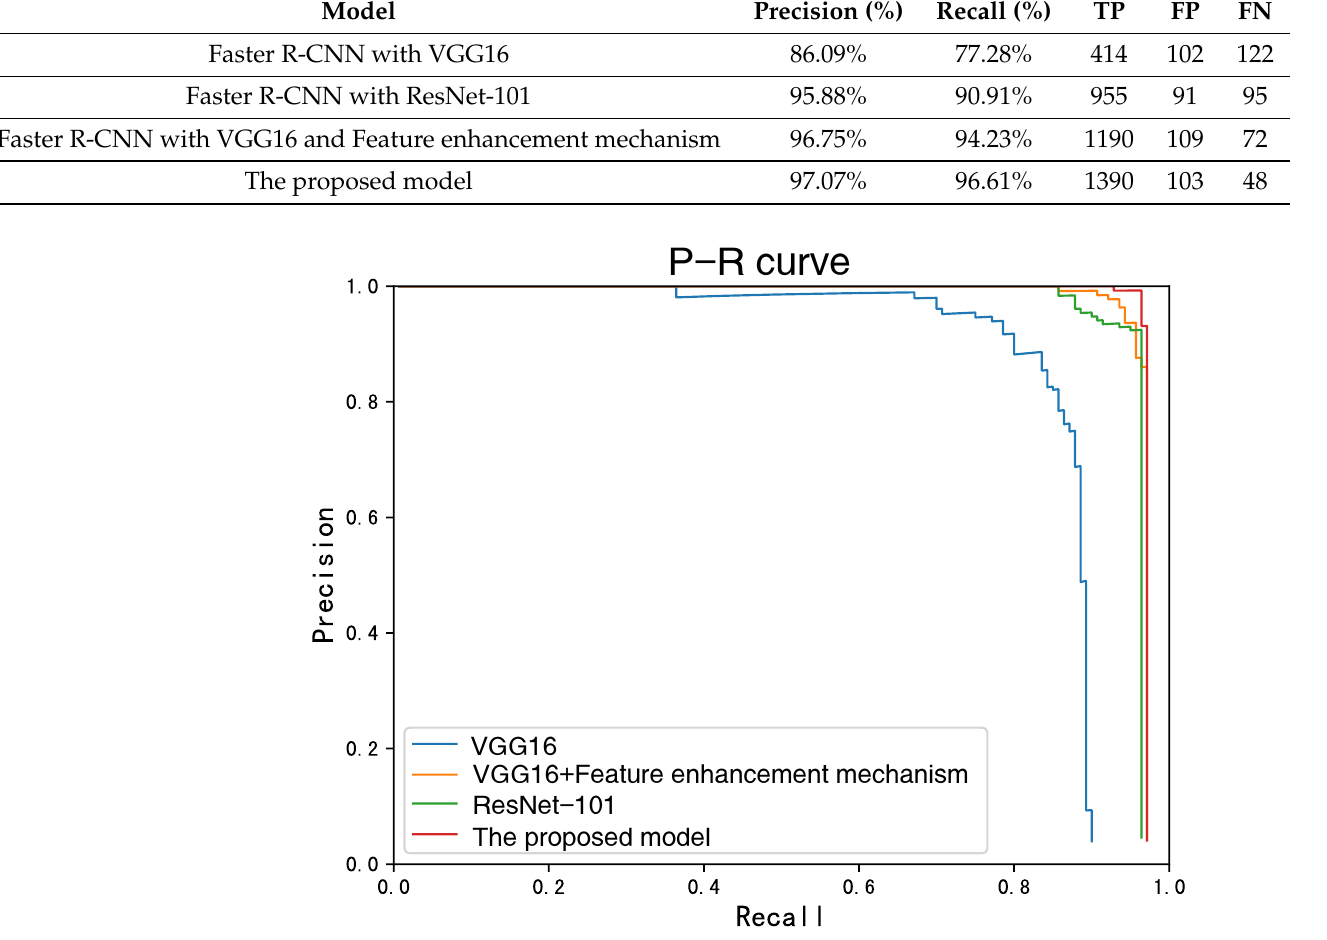
Figure 15. P-R curve of the models for comparison. The closer the curve is to the right-hand top corner, the better the detection performance will